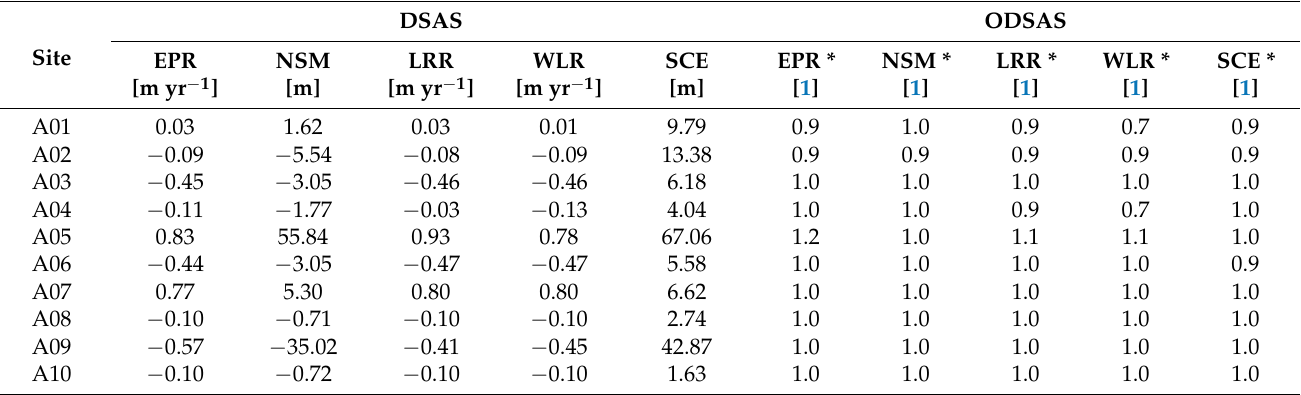
Table 4. Aggregated EPR, NSM, LRR and WLR results for all transects at each site, for both DSAS and ODSAS